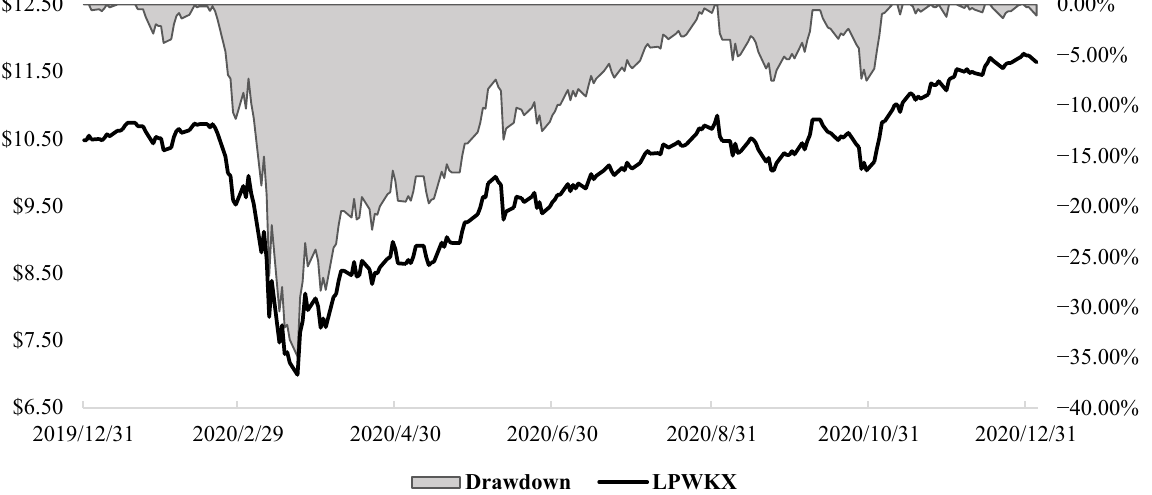
Figure 3. LPWKX Price and Drawdown over Sample Period.